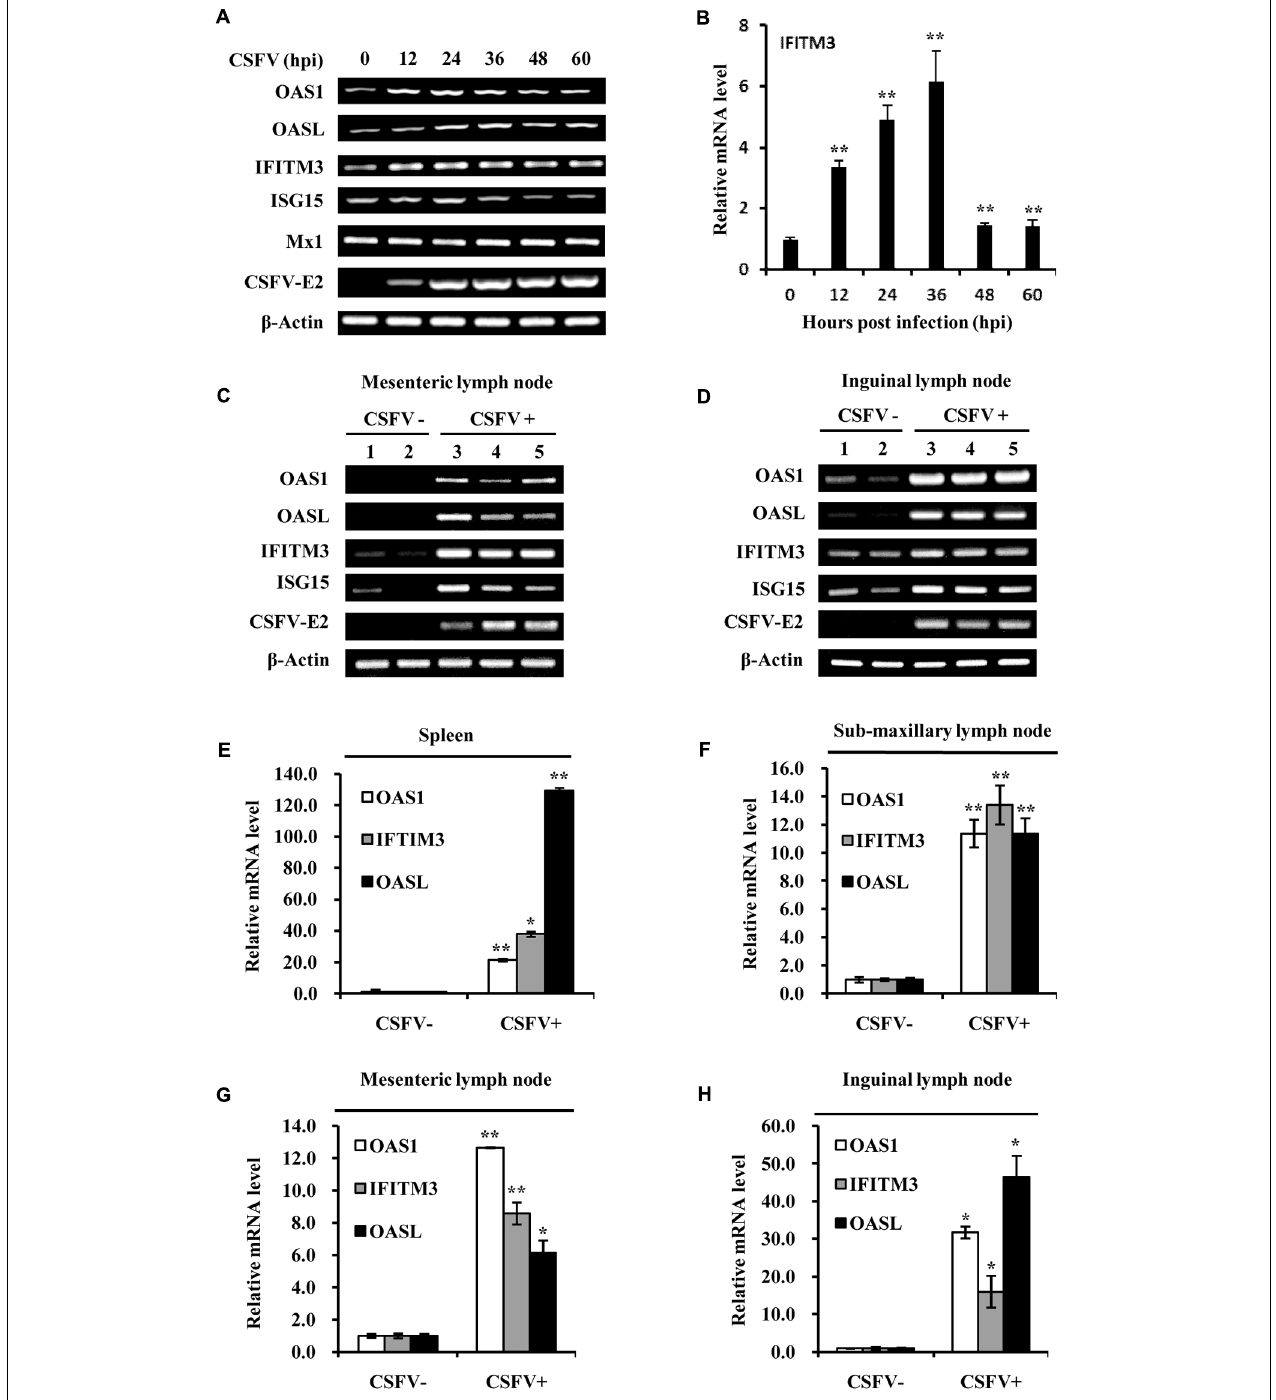
FIGURE 5 | Classical swine fever virus infection elevates the mRNA levels of several critical ISGs in vitro and in vivo . (A) PK-15 cells were infected with or without CSFV and harvested at the indicated time, followed by RT-PCR analysis of indicated genes. (B) Quantitative real-time PCR analysis was performed to determine the mRNA levels of IFITM3 in PK-15 cells infected with CSFV for indicated time. Plotted are the average results from three independent experiments. Expression of indicated ISGs and CSFV E2 gene was examined by RT-PCR analysis in (C) mesenteric lymph node and (D) inguinal lymph node of pigs infected with CSFV for 5 days. Quantitative real-time PCR analysis was performed to examine the mRNA expression of OAS1, OASL, and IFITIM3 in (E) spleen, (F) sub-maxillary node, (G) mesenteric lymph node, and (H) inguinal lymph node of pigs infected with CSFV for 5 days. Plotted are the average results from three independent experiments. ∗ P < 0.05, ∗∗ P <